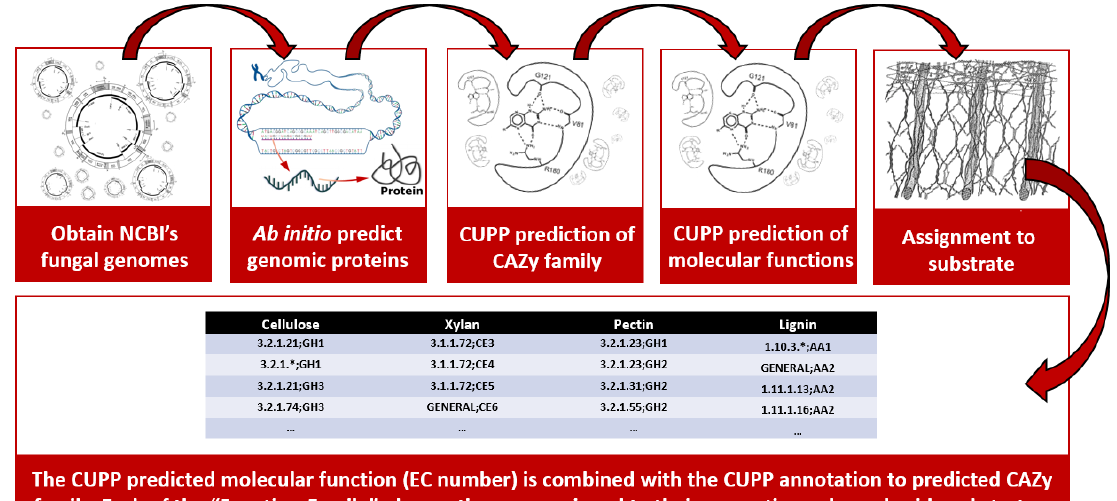
Figure 1 . Flow diagram describing the steps from downloading the full fungal genomes from NCBI and prediction of genomic proteins using AUGUSTUS. The carbohydrate-active enzymes were assigned a CAZy family and molecular function prediction via CUPP (see text). The predicted Function;Family observations were then assigned to their respective target substrates. The * indication added as fourht number in some EC numbers (molecular function numbers) indicate that no full EC number is available in the CAZy database. A similar molecular function (same EC number) from two different CAZy families are considered as two different observations by combining the EC number and the CAZy family into a combined string.